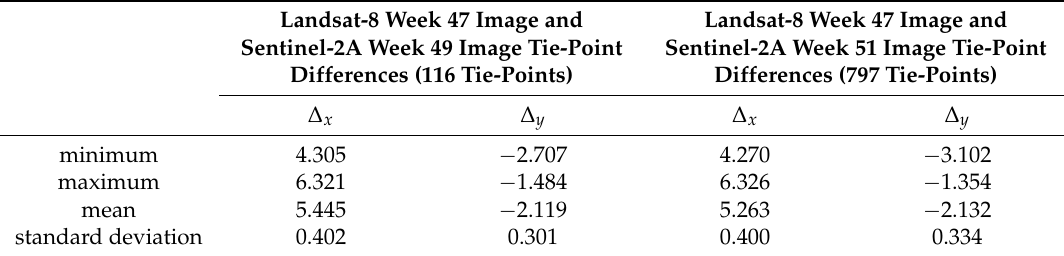
Table 2. Cape Town transformation coefficients and RMSE (Equation (5)) derived by fitting the 116 tie-points extracted from the Landsat-8 week 47 image and Sentinel-2A week 49 image. Translation